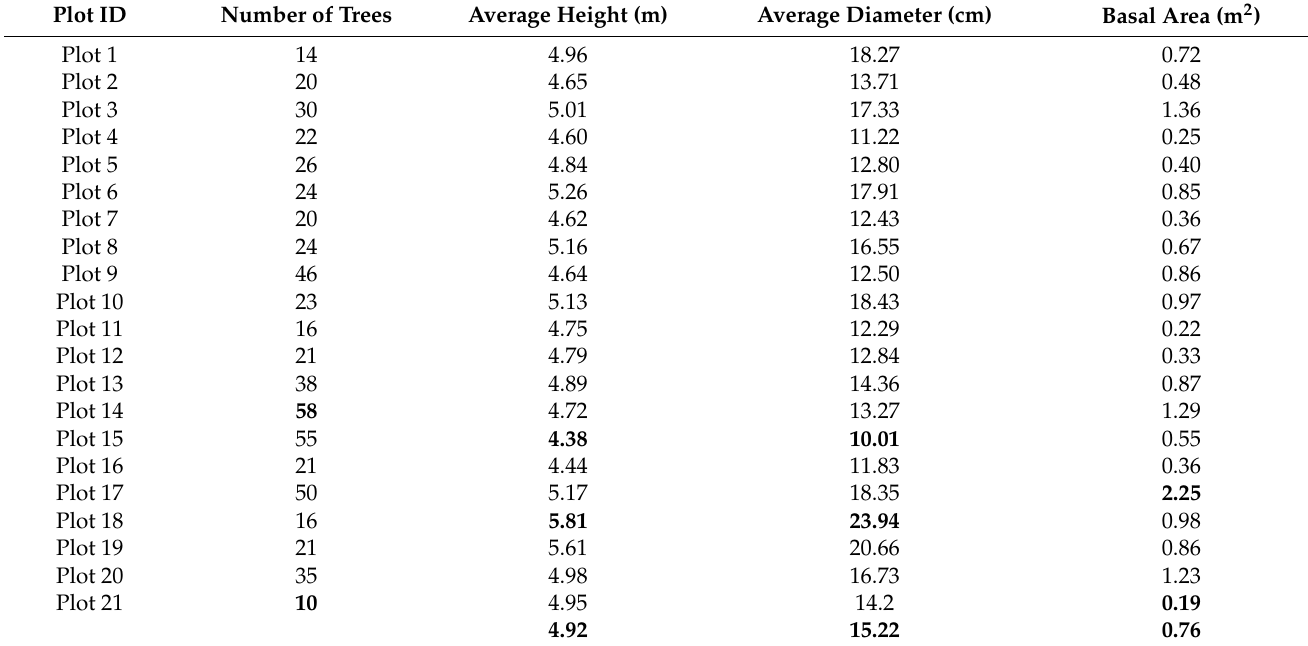
Table 4. Parameter estimation of sampled